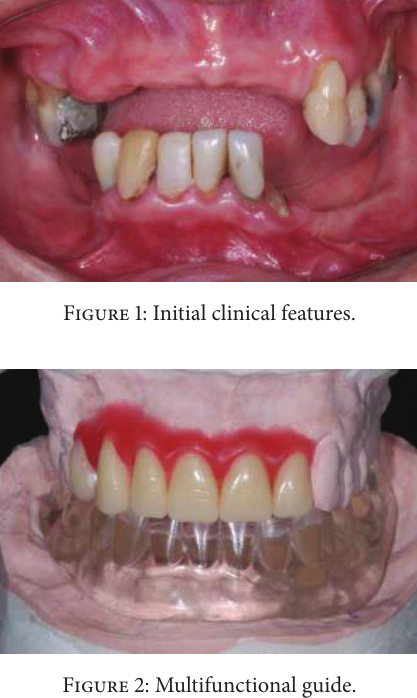
Figure 4: Fragments previously cast in Ni-Cr alloy inserted into the space between the